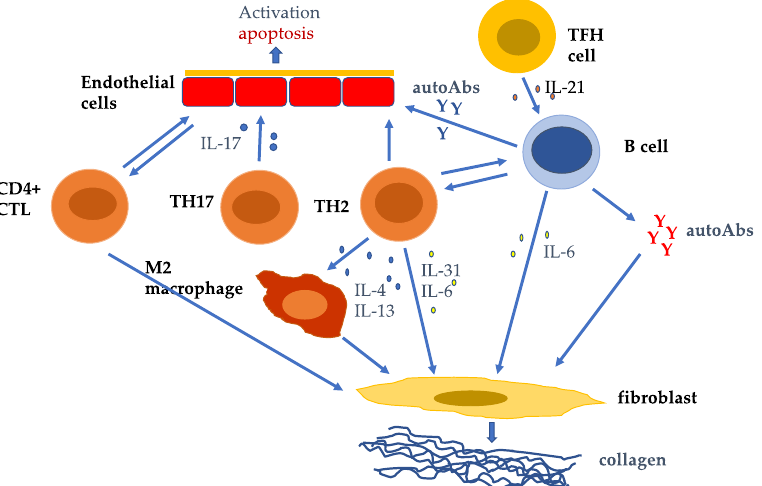
Figure 1. T cells are key players in the pathogenesis of systemic sclerosis (SSc) promoting autoAb production, fibrosis, and vasculopathy. TH2 cells and cytotoxic T lymphocytes (CTLs) predominate in SSc. TH2 cells producing IL-4, IL-13, IL-31, and IL-6 induce fibroblast collagen production. CD4+CTLs induce fibrosis and endothelial cell cellular cytotoxicity. TH17 cells induce endothelial cell adhesion molecules, chemokines, IL-1, and endothelial cell apoptosis [90]. TH2 and TFH cells help B cell production of autoAbs which activate fibroblast collagen synthesis and endothelial cell activation and